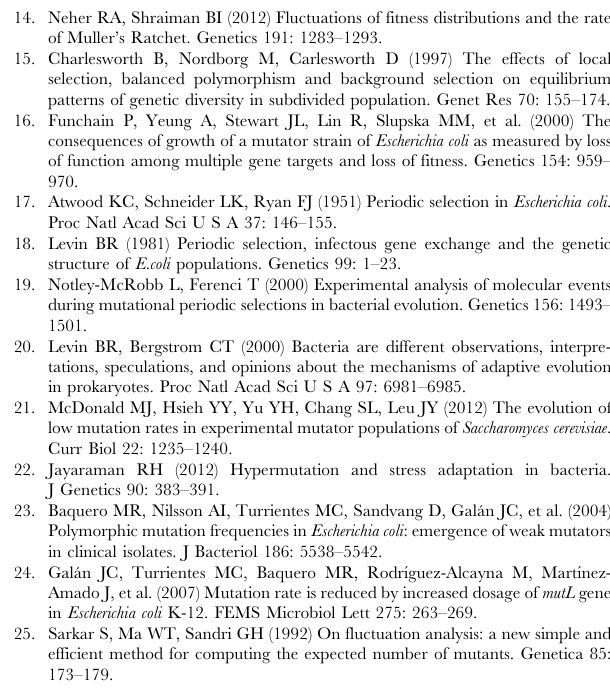
Figure S7 Genome alignment of the two normo-mutable strains t 151 and t 180 against the ancestor strain t 0 . The genomes of t 151 and t 180 normo-mutable strains, aligned with progressive MAUVE against the ancestor strain t0, show a global view of their similarity blocks. The different colour blocks interconnected by colour lines represent blocks of sequence similarity between the genomes. Blocks under the alignment black line are fragments that establish their similarity relationship with a reverse orientation of their sequence with respect to the flanking blocks. The red vertical bars limit the different contigs of each genome. The genomes show large blocks of similarity with some insertions/deletions of small fragments (white colour regions into the colour blocks). Some transposition events can be observed as expected considering the high frequency of transposases. Most of the deletions/insertions are in phage regions and in plasmid contigs or are related with different allocations of the transposases active in each genome. Based on MAUVE alignment results the insertions, deletions and SNPs were exhaustively analysed along the genome. Figure S8 Genome alignment of the two evolved mu- tator strains t 151 and t 180 against the ancestor strain t 0 . The genomes of t 151 and t 180 evolved mutator strains, aligned with progressive MAUVE against the ancestor strain t0, show a global view of their similarity blocks. The blocks, regions, and bars, and comments correspond to those in Figure S7. Figure S9 Distribution of the proportion of colonies with high and low mutation frequencies along four successive periods. ( A ) At the top, distribution of f values in 20 colonies of the ancestor strain; below, distributions of f values in 45 colonies from 15 different passages belonging to each one of the 1 st (from 13 th to 53 rd passage), 2 nd (from 58 th to 93 rd passage), 3 rd (from 97 th to 138 th passage) and 4 th (from 141 st to 180 th passage) periods respectively (see text S7 in File S2, is the same as Figure 3;